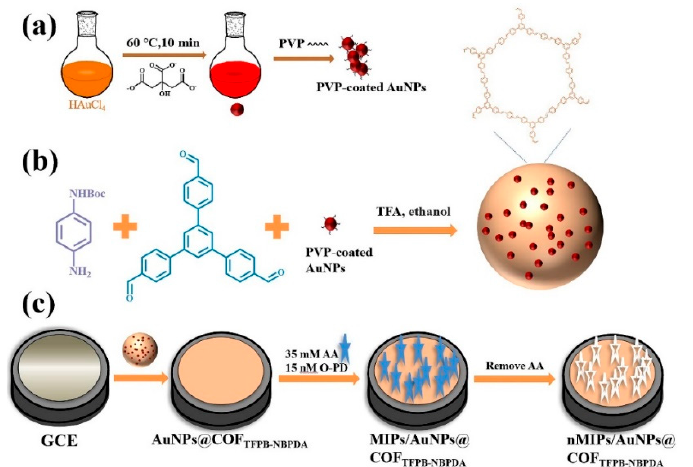
Figure 1. Schematic diagram of the preparation process of ( a ) PVP-coated AuNPs, ( b ) AuNPs@ COF TFPB-NBPDA , and ( c ) nMIP/AuNPs@COF TFPB-NBPDA